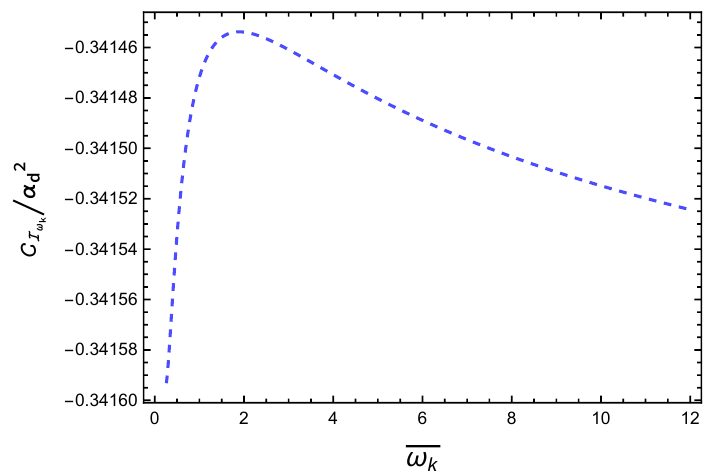
, signifying the concurrence, is plotted for two outgoing null Figure 9 . The quantity C I /α 2 d ωk detectors in a (1 + 1) dimensional de Sitter spacetime with respect to the dimensionless frequency of the field ω = ω for fixed dimensionless detector transition energy ∆ E = ∆ E α k k α d other fixed parameter is d/α = 0 d